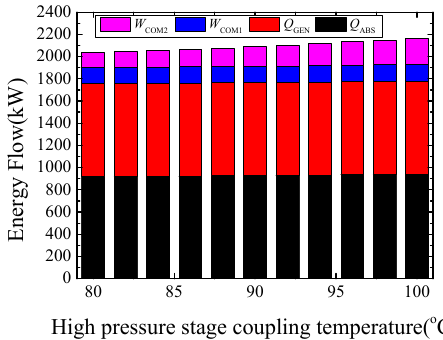
Figure 11. Effect of high pressure stage coupling temperature on the energy flow.